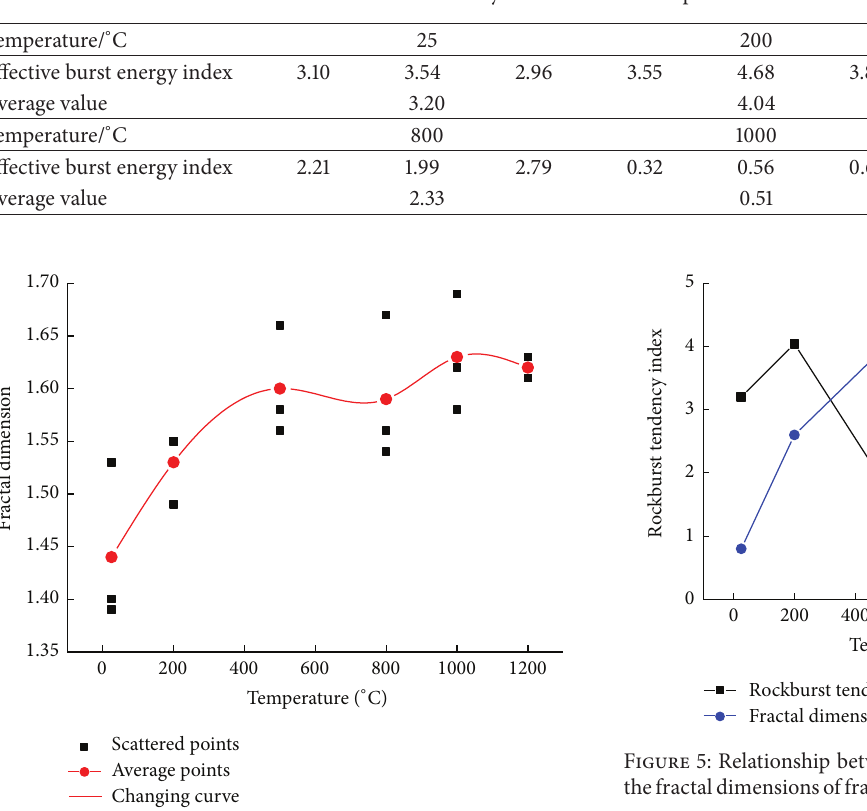
Table 2: Rockburst tendency indexes of rock samples after different temperature.